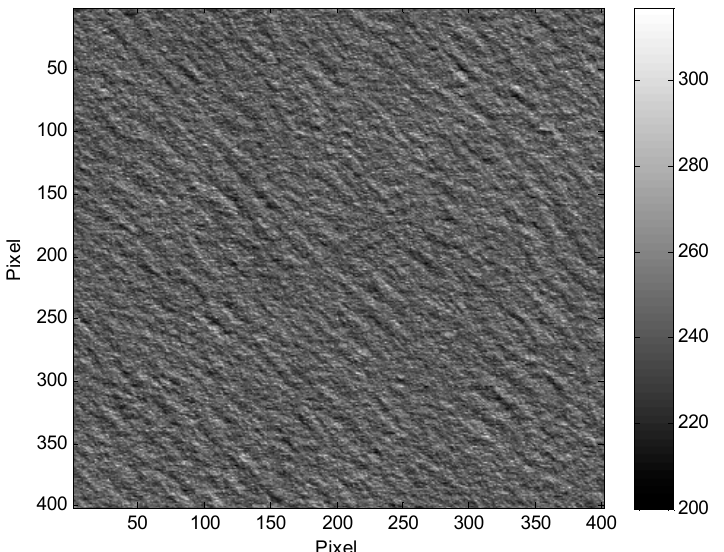
Figure 4. Example of a slope distribution extracted from GF-1/WFV3 level 1A image. The size of one pixel is 16 m × 16 m. The Digital Number (DN) values are between 210 and 307.